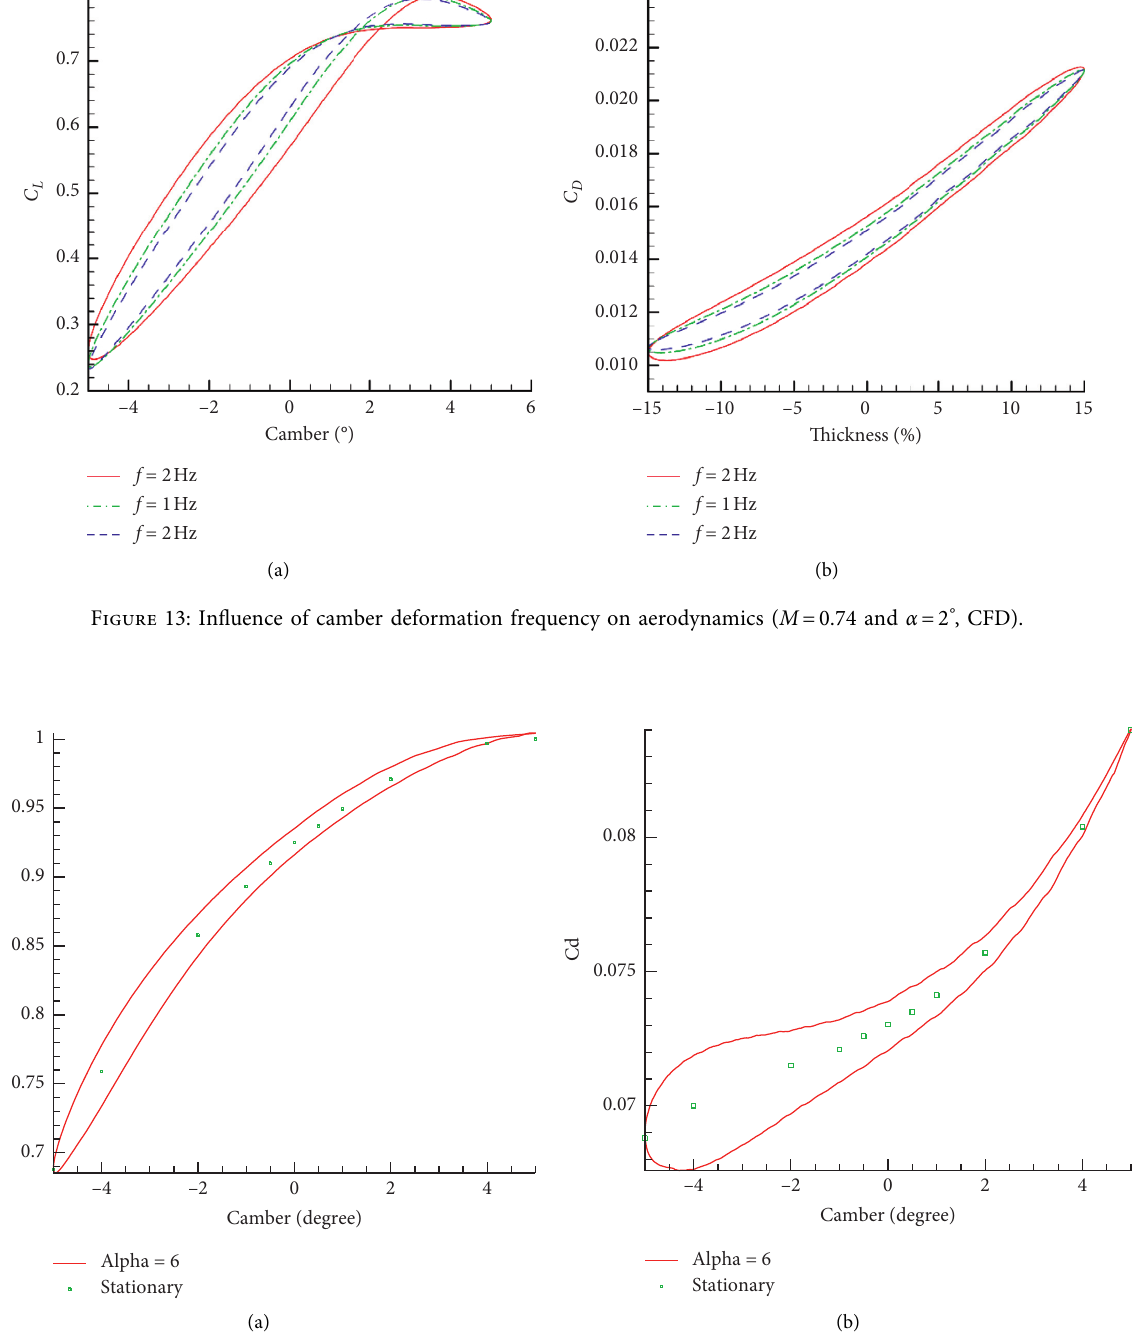
Figure 14: Influence of camber changing on aerodynamics ( M � 0.74, α � 6 ° , and f � 1Hz,